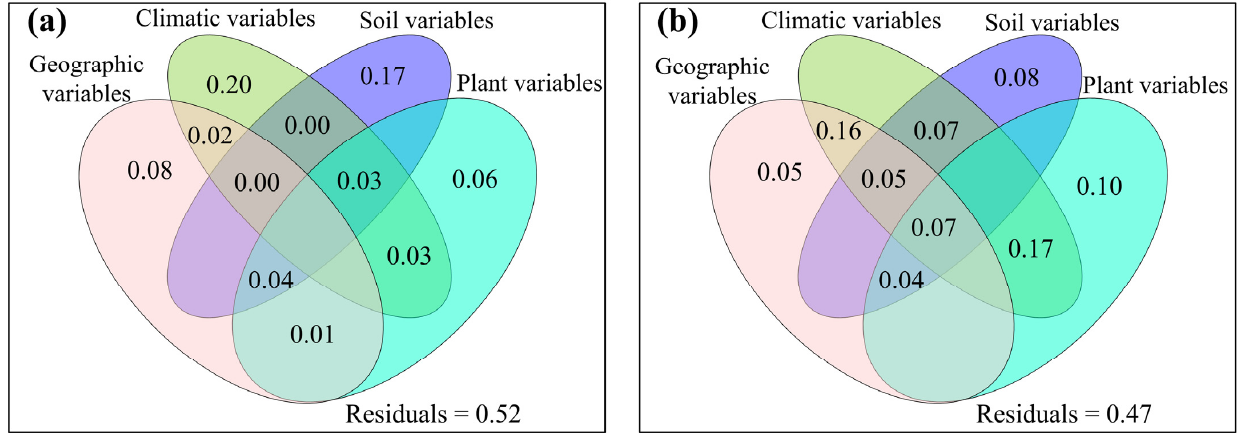
Figure 5. The mutual as well as excluded impacts of geographic variables, climatic variables, soil variables and plant variables on total abundance for ( a ) topsoil and ( b ) subtopsoil, respectively.